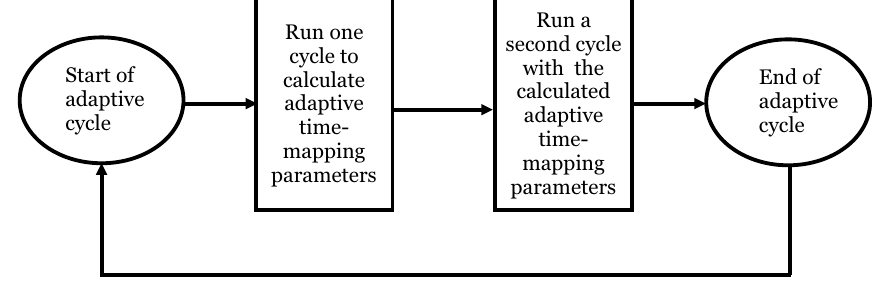
Figure 3. An illustration of adaptive time-mapping procedure.